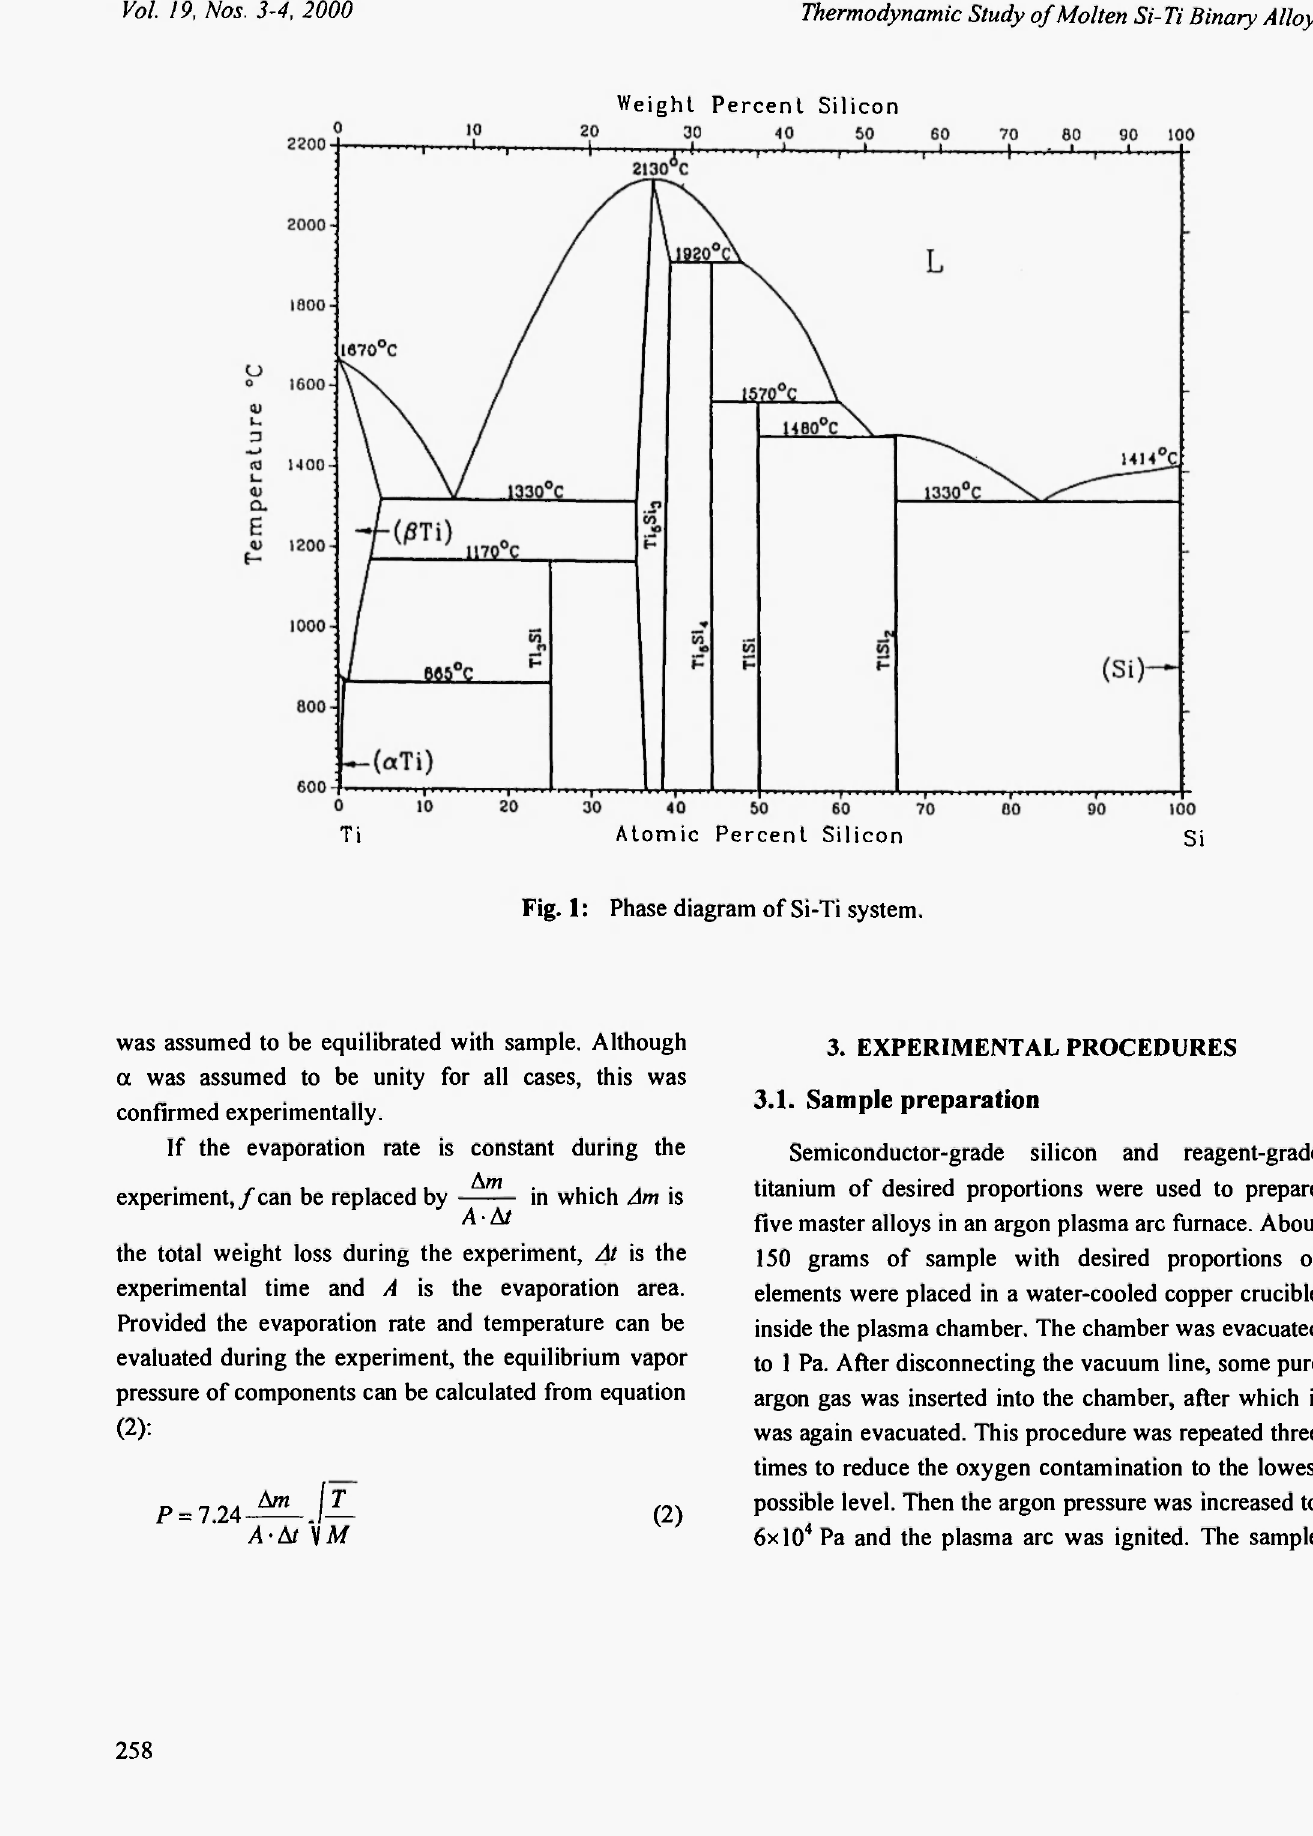
Fig. 1 : Phase diagram of Si-Ti